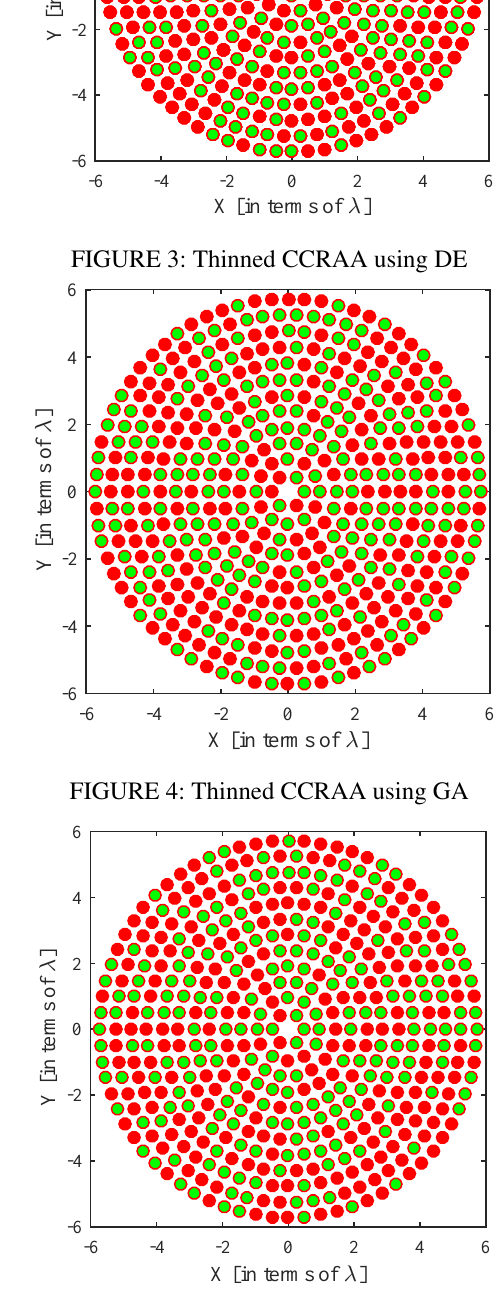
FIGURE 5: Thinned CCRAA using